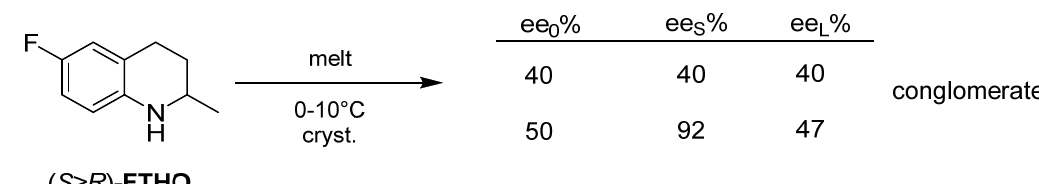
Figure 17. The common intermediate of prostaglandins can be purified by melt crystallization, the Figure 18. The S enantiomer of FTHQ crystallizes out of purer fraction always ends up in the crystalline phase.